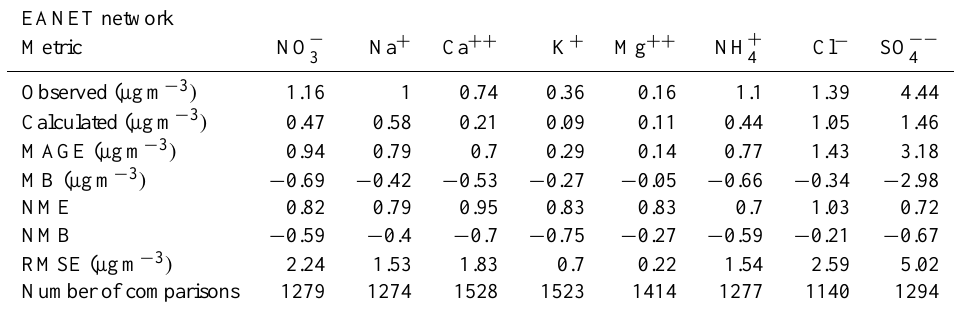
Table 4. Statistical evaluation of EMAC-simulated aerosol concentrations against monthly average observations from East Asia during